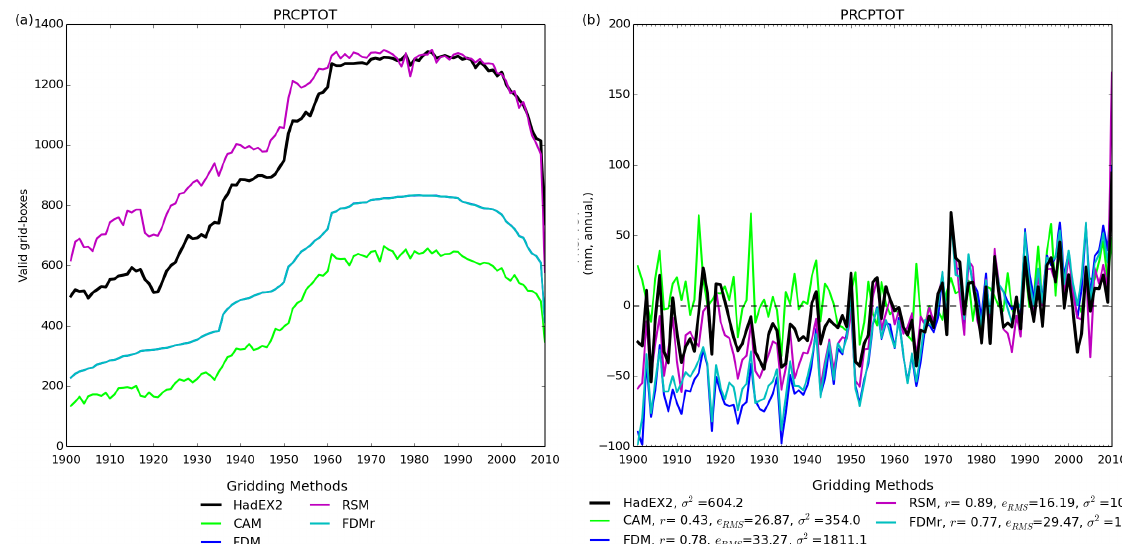
Figure 15. (a) The number of non-missing grid boxes and (b) the time series for global average PRCPTOT (total annual precipitation) for the five different gridding methods. Note that the global average only takes grid boxes which have 90% completeness or more, whereas all grid boxes are shown in the coverage series. All choices have been centred relative to the climatology period 1961–1990, reducing the spread during this time.